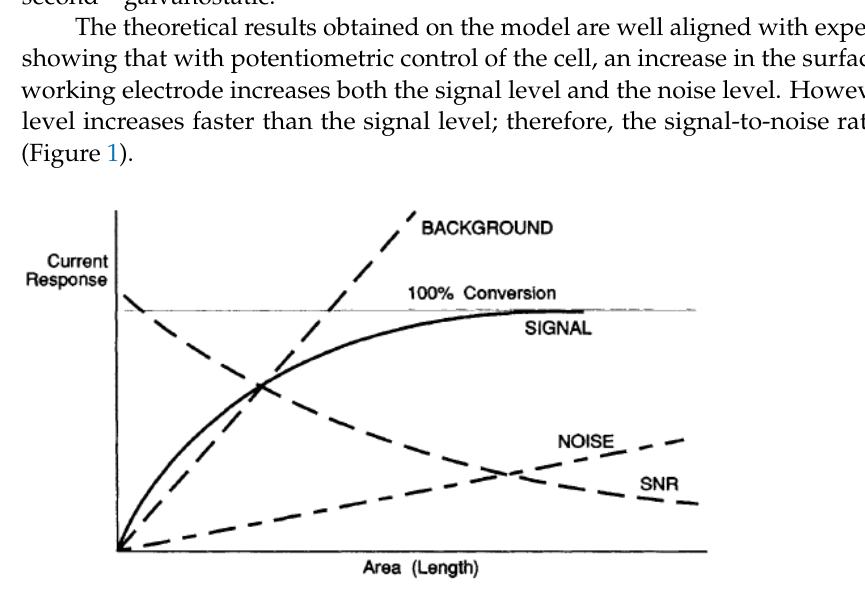
Figure 1. The nature of the change in the main parameters of the analytical signal with an increase in the size of the working electrode [8] (p. 50, Figure 6), adapted with the permission from ref. [8], Elsevier, 1993.